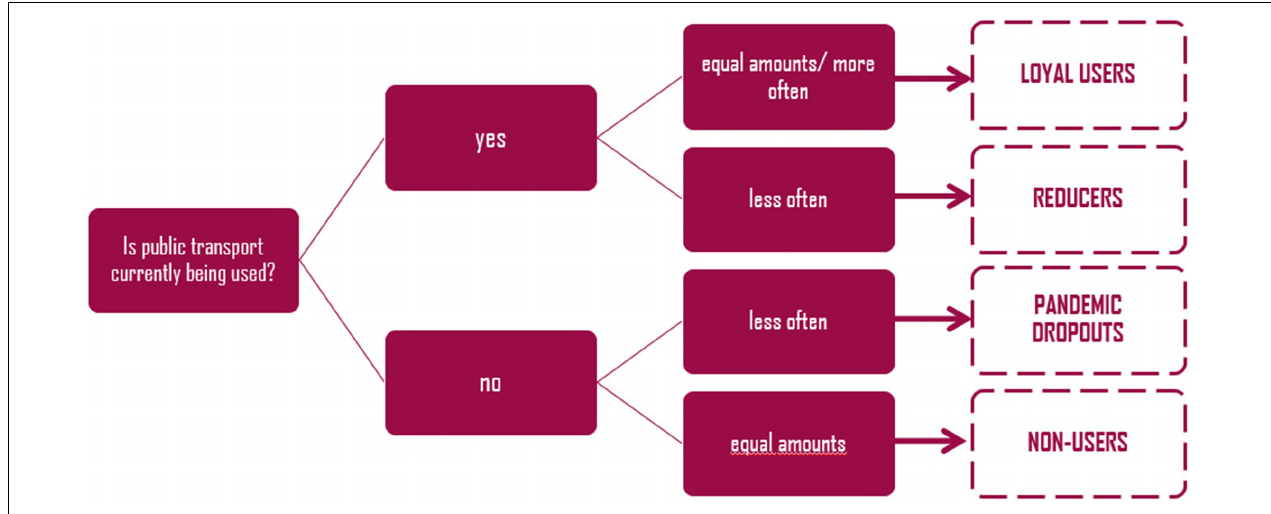
FIGURE 1 | Target groups of public transport use during the